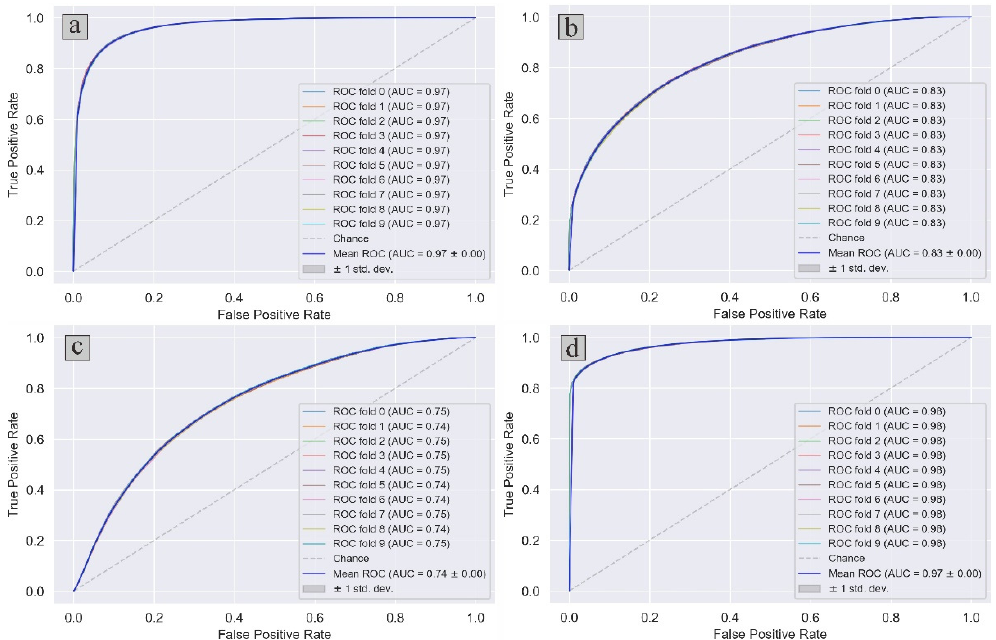
Figure 7. Receiver Operating Characteristic Curve (ROC) and AUC using 10-times cross validation. ( a ) RF model of unclassified landslides, ( b ) GB model of landslide age, ( c ) GB model of landslide size, ( d ) GB model of landslide type.